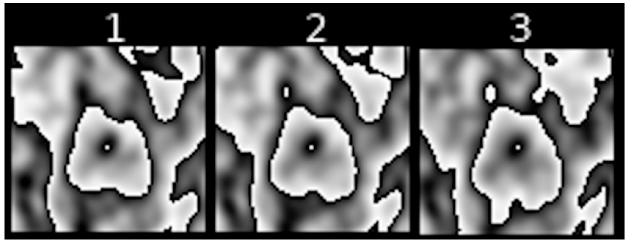
Figure 10. Example of a slight shift in the location of maximum [18F] FDG uptake in a sequence of PET images of a pulmonary nodule.